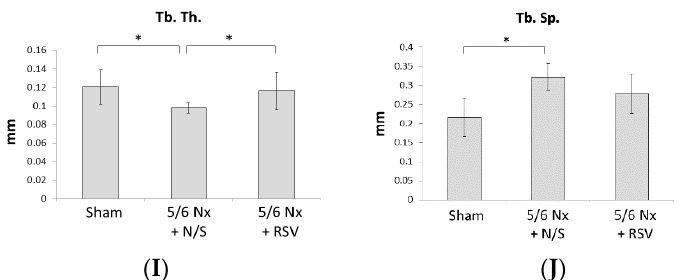
Figure 1. Resveratrol (RSV) ameliorates the impaired bone quality of mice with impaired renal function. BALB / c male mice were divided into three groups: sham + normal saline (N / S) treatment; 5 / 6 Nephrectomy (Nx) + N / S treatment; and 5 / 6 Nx + RSV treatment ( n = 6 in each group) ( A , B ). After 4 weeks of surgery and before injection treatment, the serum levels of creatinine and blood urea nitrogen (BUN) of the 5 / 6 nephrectomy groups were significantly elevated compared to the sham group. ( C ) After 4 weeks of injections, H&E staining applied to the bone tissue showed the chondrocyte rows of the 5 / 6 Nx + RSV group to be more orderly than those of the 5 / 6 Nx + N / S group. Scale bar = 0.2 mm. ( D ) Immunohistochemical (IHC) staining with DAB represents the preservation of Runx2 expression (brown particles). ( E ) The relative interest of density (IOD) values of Runx2 in bone tissue showed that the 5 / 6 Nx + N / S group has the lowest expression. Scale bar = 0.2 mm. ( F ) The micro-CT images showed that the cancellous bone tissue and epiphyseal plate (red arrows) in the distal femur metaphysis of 5 / 6 Nx + RSV group were increased and thicker, respectively, compared to the 5 / 6 Nx + N / S group. ( G ) The micro-CT analysis data reveal that the bone volume over total volume (BV / TV) in the 5 / 6 Nx + N / S group was significantly decreased in comparison with the sham group, but the 5 / 6 Nx + RSV group shows an increasing trend compared to the 5 / 6 Nx + N / S group. ( H , I ) In terms of trabecular number (Tb. N) and trabecular thickness (Tb.Th), the values of the 5 / 6 Nx + N / S group significantly decreased compared to the sham group, and those of the 5 / 6 Nx + RSV group significantly increase compared to the 5 / 6 Nx + N / S group. ( J ) In terms of trabecular separation (Tb.Sp), the values for the 5 / 6 Nx + N / S group here are significantly increased compared to the sham group, but the 5 / 6 Nx + RSV group showed a decreasing trend compared to the 5 / 6 Nx + N / S group. Data are represented as the mean ± SEM ( n = 6). * Indicates di ff erences that are considered significant between the indicated groups ( p < 0.05).